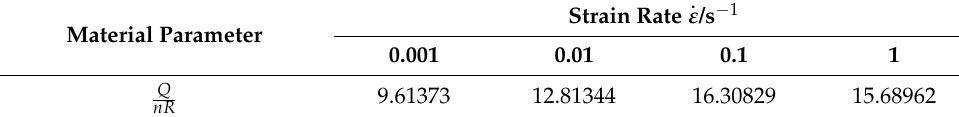
Table 5. The regression analysis results of hyperbolic sine function of temperature and ε 0.3 .